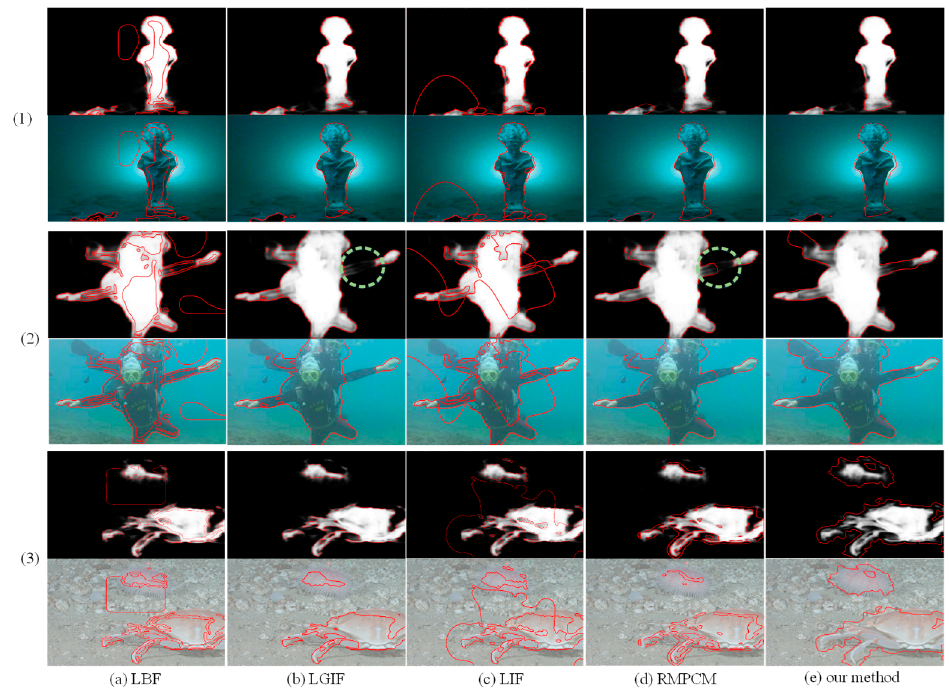
Figure 7. Comparison of our method with LBF, LGIF, LIF, RMPCM. ( a – e ) Results of LBF, LGIF, LIF, RMPCM, and our method. The upper rows of (1), (2), and (3) are the segmentation results of the saliency images, and the lower rows are the segmentation results of the corresponding original images.